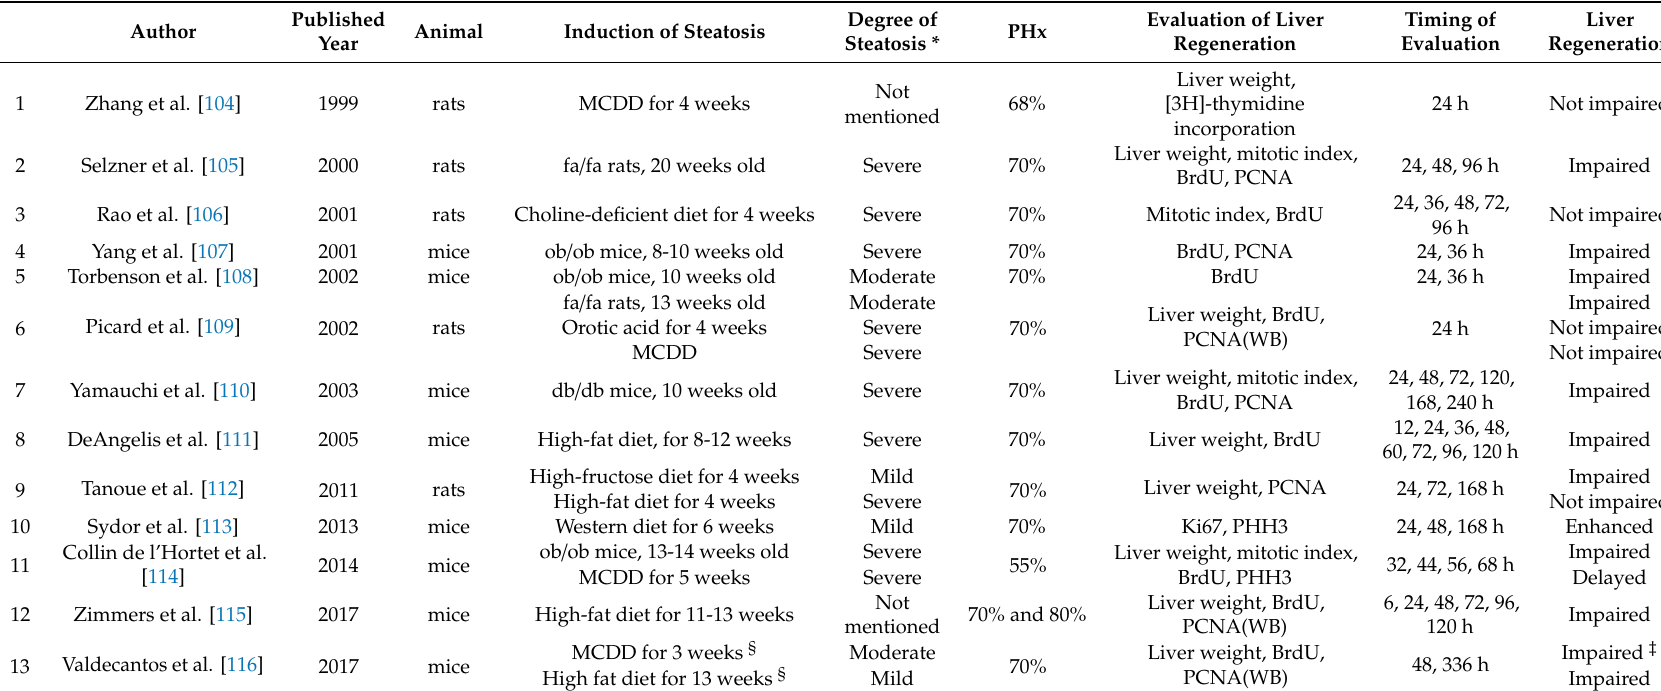
Table 1. Summary of experimental studies on liver regeneration after partial hepatectomy (PHx) of steatotic liver (separate